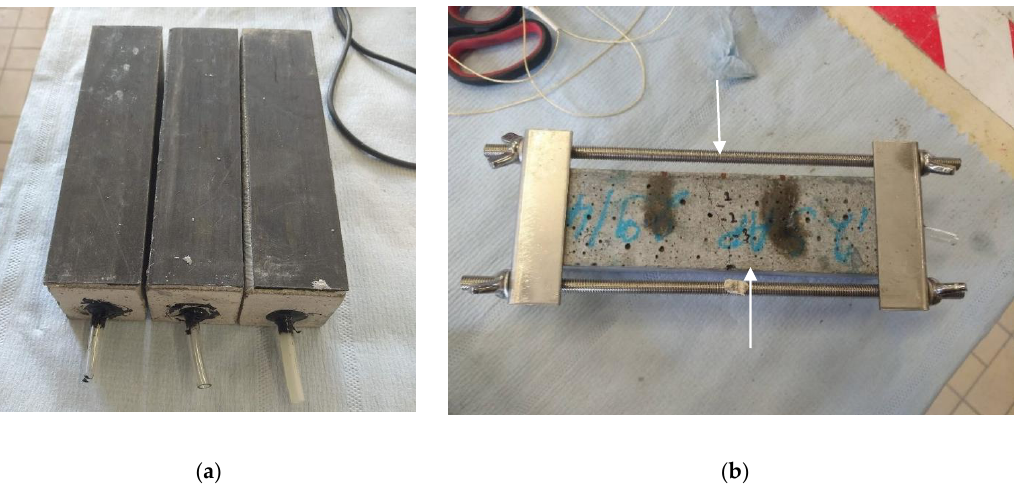
Figure 1. View of the prism samples: ( a ) top view with CFRP laminate and connected tubes and ( b ) bottom view with restraining framework showing a specimen with a crack in the middle part. The depicted arrows show the boundaries of the crack near the side After preparation of the samples, wet–dry cycles were performed during 40 days on five out of six samples: 23 h dry at 20 ± 2 °C and a relative humidity (RH) of 60% ± 5% and 1 h in water at 20 ± 2 °C per day. The remaining specimen was placed in an air-conditioned room at 20 ± 2 °C and 60% ± 5% RH. Measurement of the crack widths and water permeability were conducted at specific moments during this 40-day period and will be specified in the following sections.